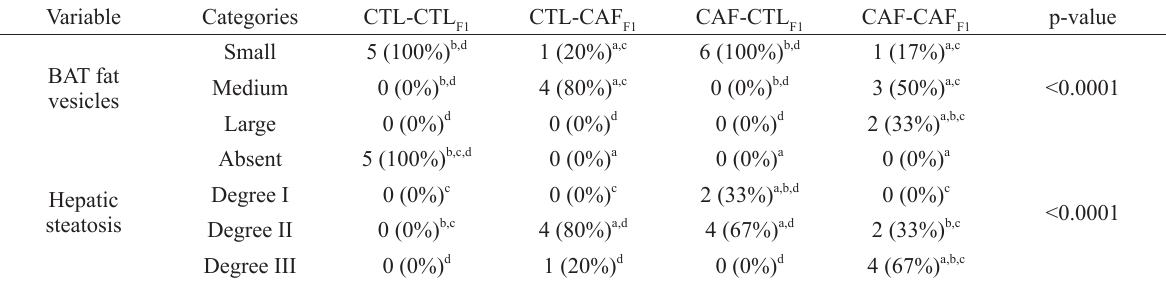
Histological analysis of BAT lipid droplets profile and lipid hepatocyte infiltration of male offspring at age 100